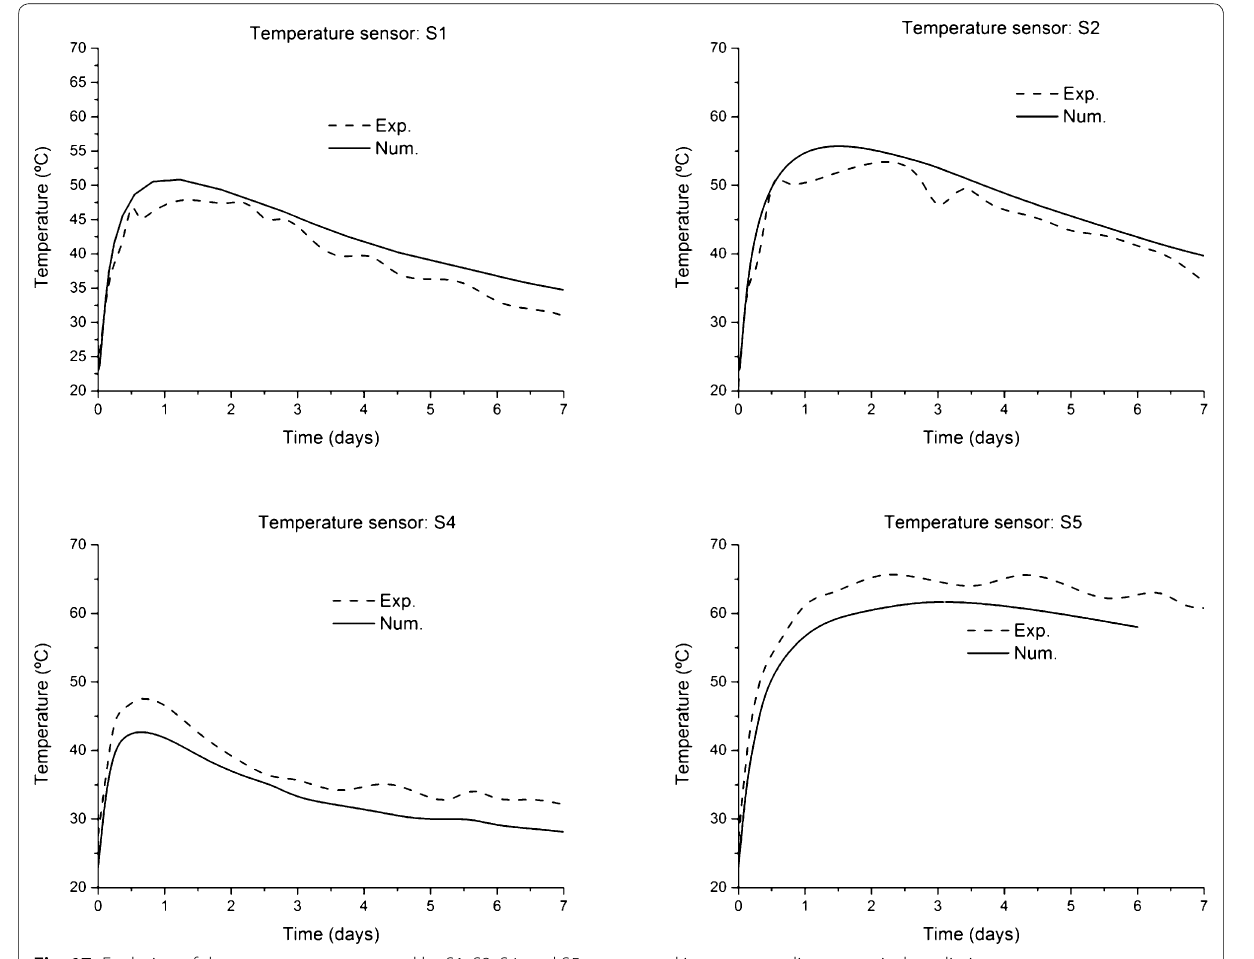
Fig. 17 Evolution of the temperature measured by S1, S2, S4, and S5 sensors and its corresponding numerical